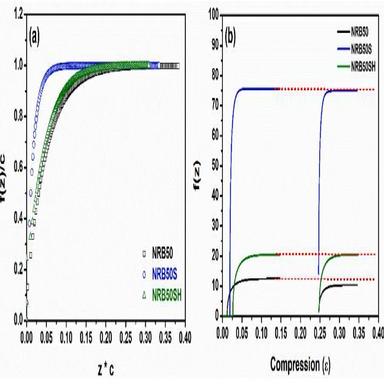
Evolution of material scale function.